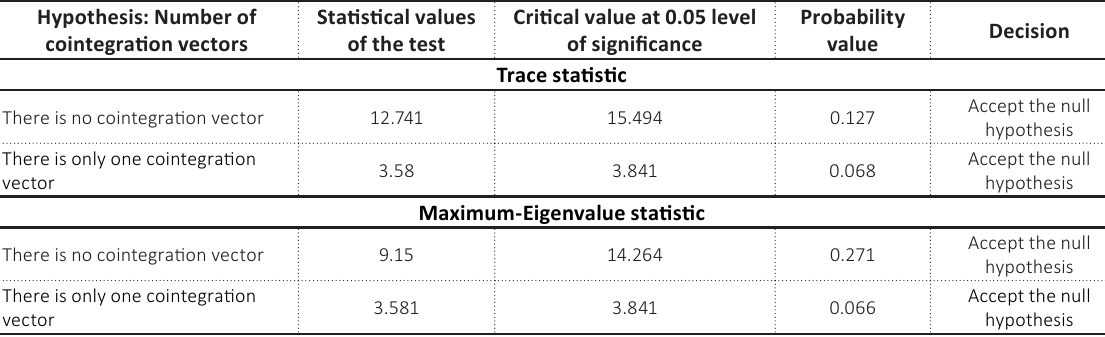
Table 4. Johansen cointegration test results